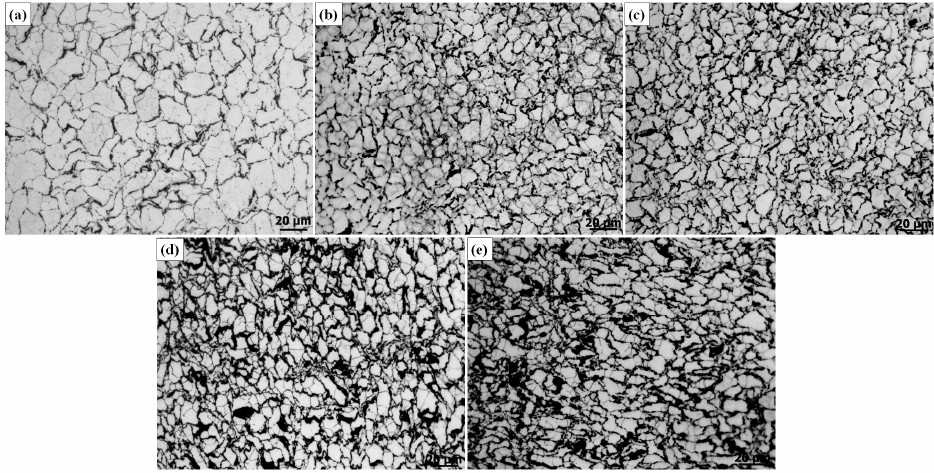
Figure 3. OM (optical microscope) graph of the as-extruded AZ31 and its nanocomposites: ( a ) AZ31, ( b ) AZ31-0.5wt. %CNTs (Carbon nanotubes), ( c ) AZ31-1.0wt. %CNTs, ( d ) AZ31-2.0wt. %CNTs, ( e ) AZ31-4.0wt. %CNTs.